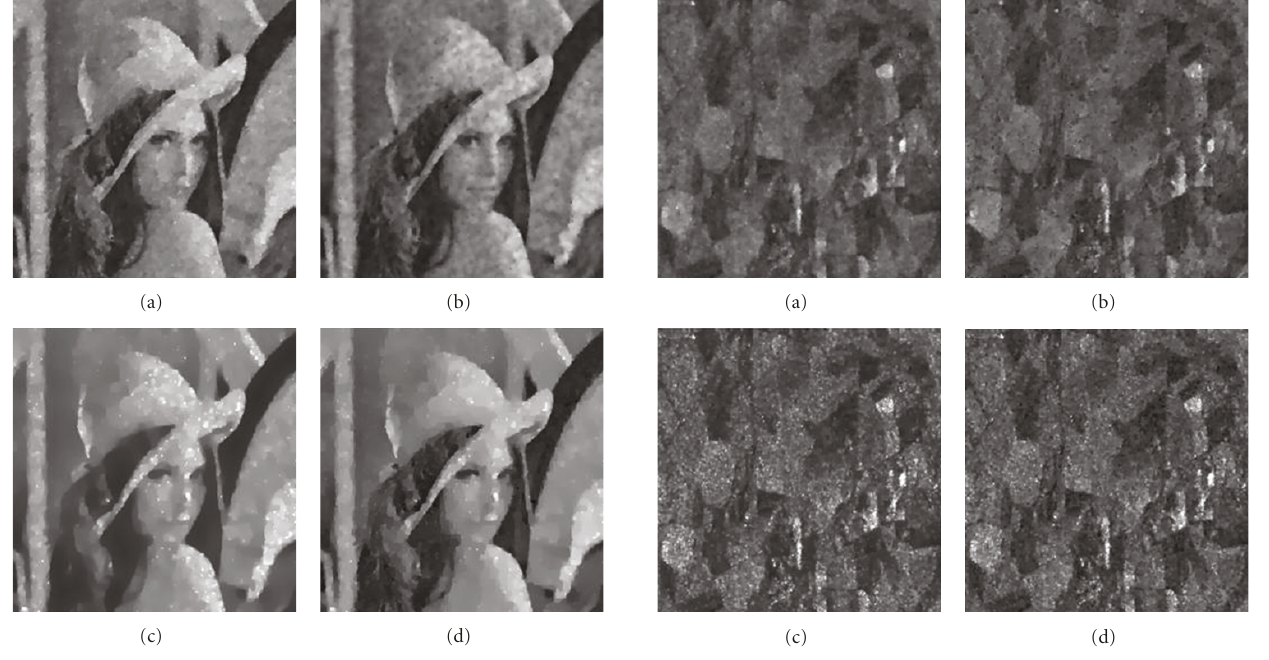
Figure 5: The restored “Lena” images for denoising Figure 2(b): (a) by the proposed method ( α 1 = 0 . 5 × 2 32 , α 2 = 0 . 2 × 2 32 , and ζ = 5 × 10 − 3 ); (b) by the “HMW” method ( α 1 = 0 . 01, α 2 = 0 . 01); (c) by the “AA” method; (d) by the “RLO” method.